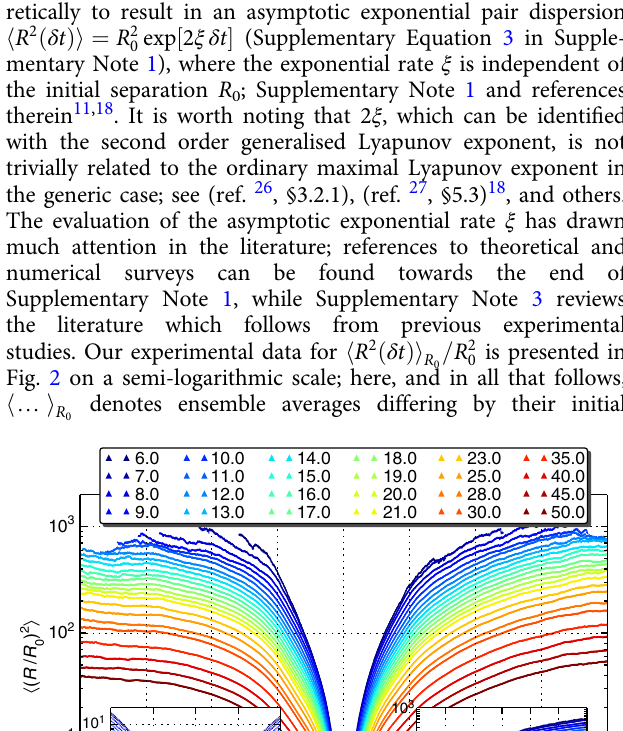
Fig. 2 Pair dispersion normalised by the initial separation. The plot shows the average squared pair separation distance, normalised by the initial separation, h R ð δ t Þ = R 0 ð Þ 2 i for various R 0 between 6 and 50 μ m; R 0 curves satisfying the asymptotic exponential pair dispersion (cid:1) (cid:3) ¼ R 2 R 2 ð δ t Þ 2 ξδ t ½ (cid:2) , Supplementary Equation 3, would show-up on this 0 exp semi-logarithmic presentation as straight lines, all sharing the same slope and, when extrapolated, hitting the origin, i.e., they should all collapse on a single linear relation. The insets present a zoom-in on the initial and intermediate temporal sub-intervals where the full range plot may seem to contain linear segments. Nevertheless, there is no unique slope which can be identi fi ed. Moreover, an exponential pair dispersion should extrapolate to the origin on this plot, which is clearly not the case here, and the curves do not merge asymptotically. The data show no supporting evidence for the exponential time dependence which follows Supplementary Equation 3. The (cid:1) un-normalised data R 2 ð δ t Þ can be found in Supplementary Fig. R 0